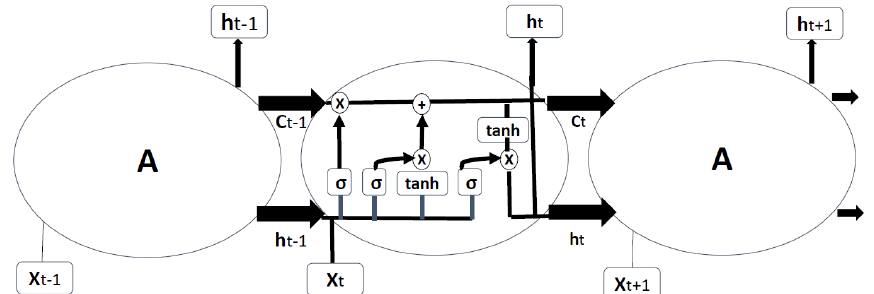
Figure 5. Structure of LSTM block with four interacting layers.